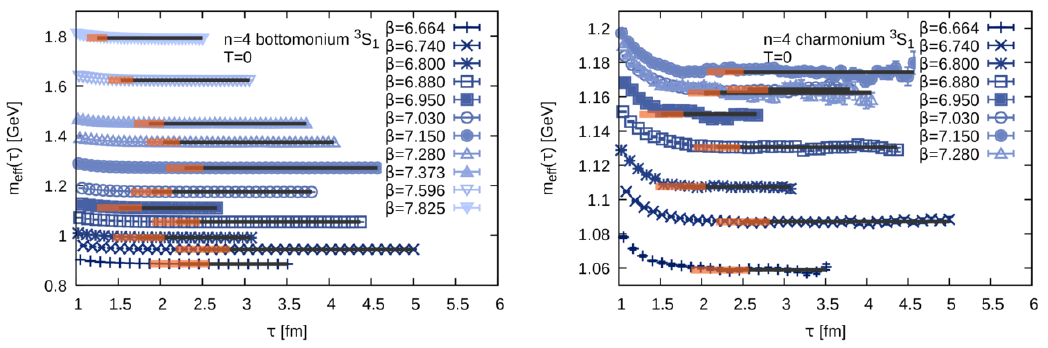
Figure 4 . Zero temperature e(cid:11)ective masses of the S-wave channel with bottomonium results on the left and charmonium on the right. We also show the average (cid:12)t interval (black solid) and its variation (orange).